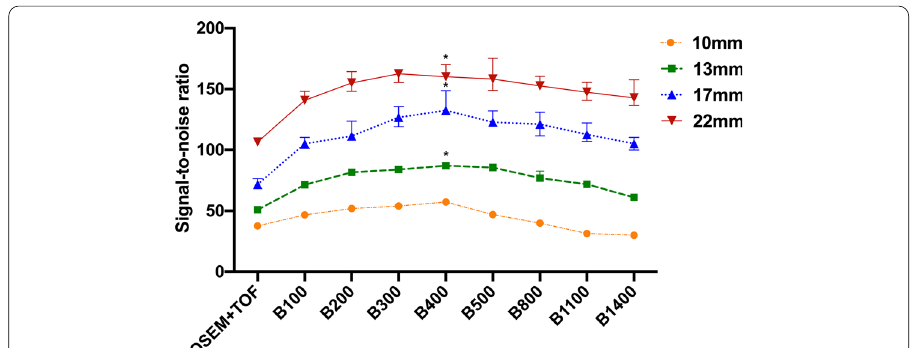
Fig. 2 SNR for all hot spheres with diameters of 10 mm, 13 mm, 17 mm and 22 mm. These were shown for OSEM TOF (3 iterations, 28 subsets, 4.0-mm filter), Q.Clear ( β + 1400). Values are presented as medians (IQRs). * represents a statistical difference compared to OSEM (Bonferroni corrected P <